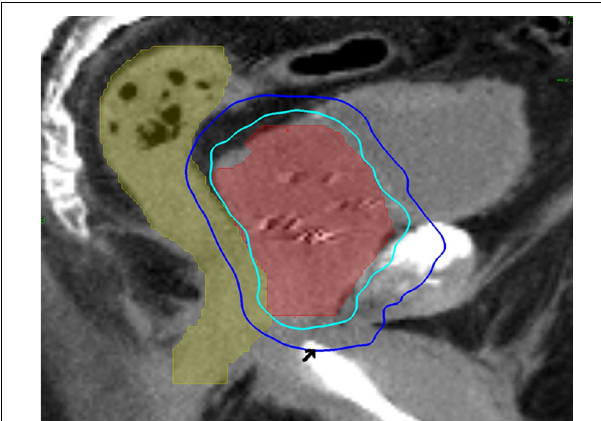
FIGURE 1 | A 60-year-old man with intermediate risk prostate cancer had cardiac disease and an internal defibrillator, which precluded magnetic resonance imaging for treatment planning . Thus, he was treated with urethrogram-directed SBRT: treatment planning sagittal computed tomography urethrogram images demonstrating the prostate (red) and rectum (green) are shown. Arrowhead marks the “beak” of the urethrogram. Isodose lines shown as follows: 100% of the prescription dose (light blue line) and 50% of the prescription dose (dark blue line).